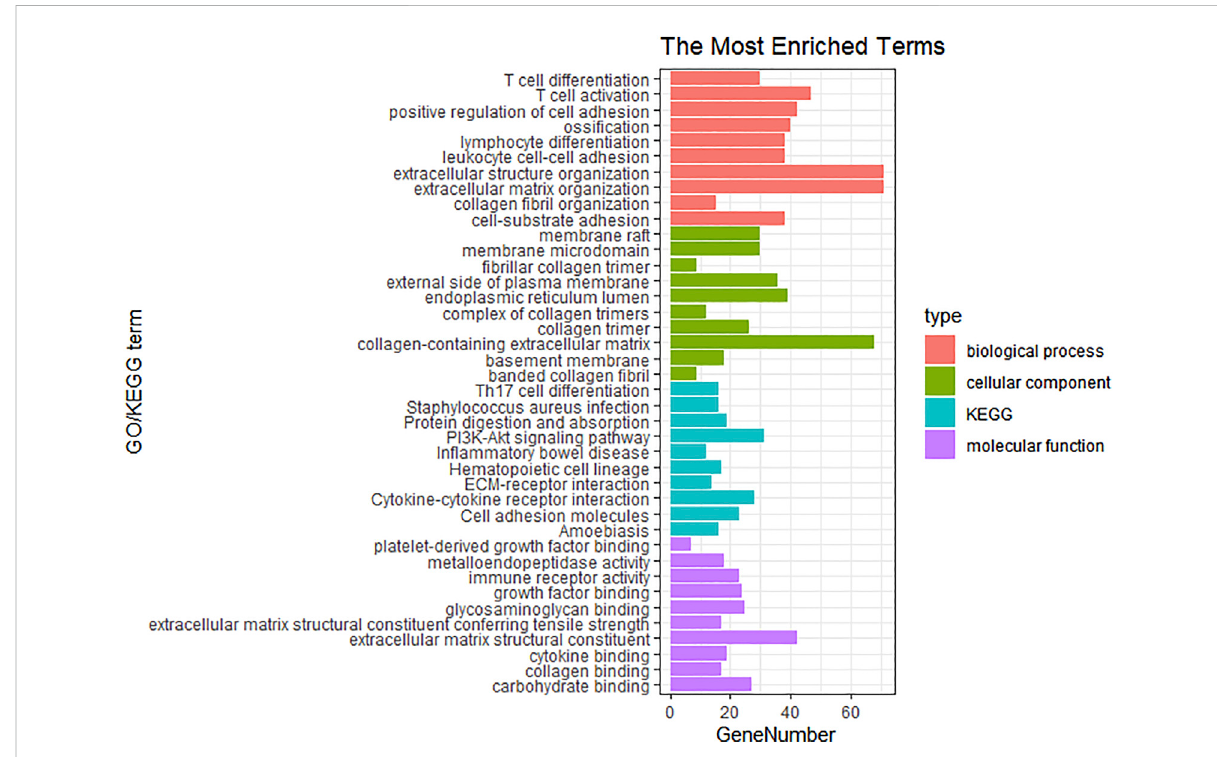
FIGURE 5 GO and KEGG analysis for the genes of brown, yellow and tan